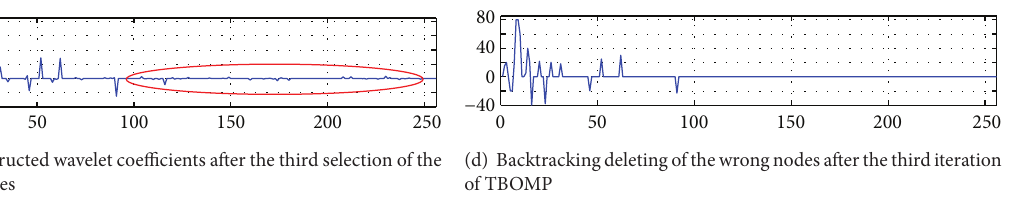
Figure 4: Reconstruction of TBOMP